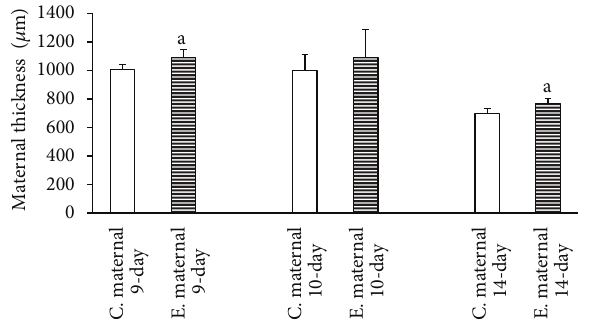
Figure1:Reviewingthegraphillustratingthetime-dependenteffect of oral morphine consumption on the development of the thickness of the maternal portion of the placenta for three different periods of pregnancy (9-day, 10-day, and 14-day pregnant mothers), and a comparison between the experimental (E) groups and the control (C) groups reveals the increase of the maternal portion of the placenta in the experimental group, compared to that of the control groups ((a) 𝑃 value of < 0.01 indicating a significant difference).